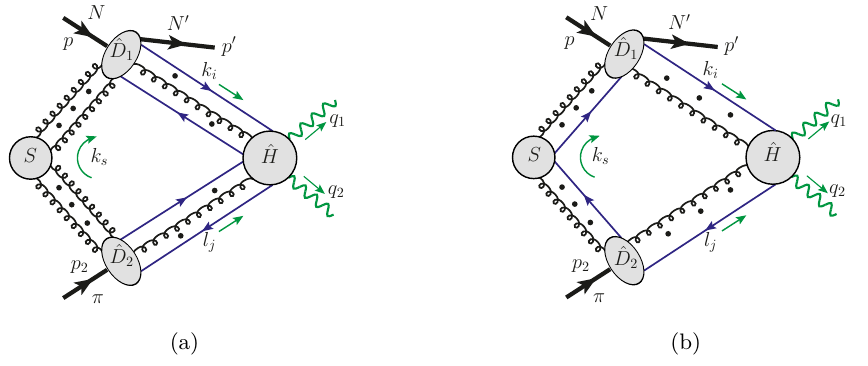
Figure 14. Two possible leading regions for the process (3.1). Arbitrary number of gluons can connect to the collinear subgraphs ˆ D 1 or ˆ D 2 from S or ˆ H , but they have to be longitudinally